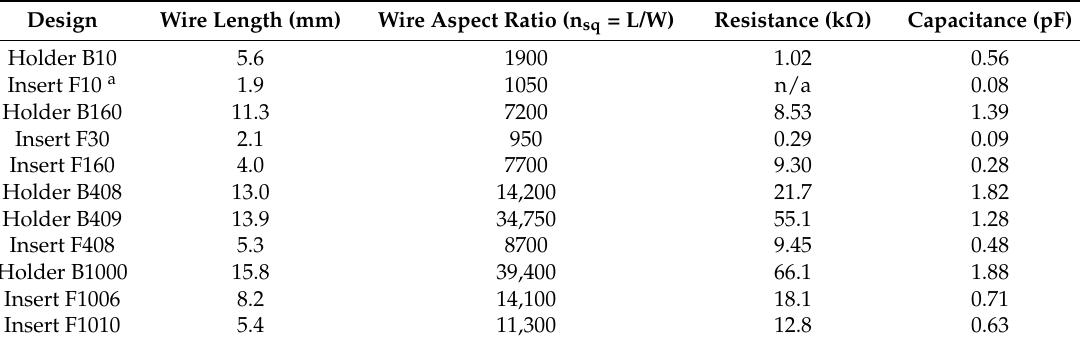
Table 5. Electrical Characterization of Probe Components. Measurement accuracy is ± 5%,